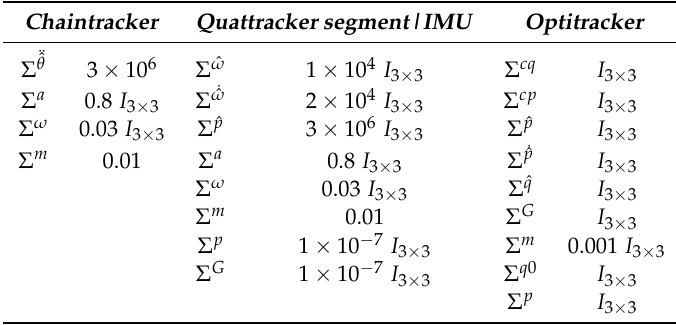
Table D1. Noise covariances used by all sensor fusion methods in all tests (cf. Table